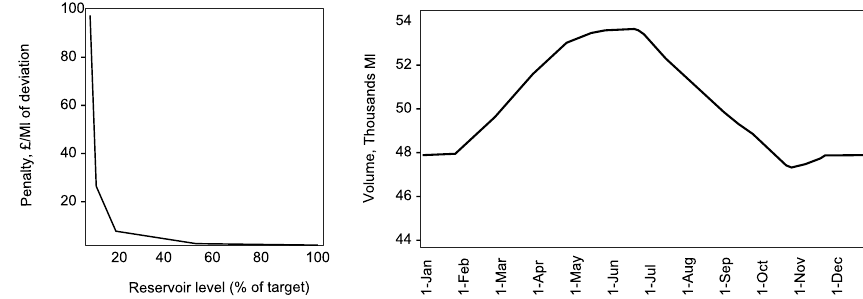
Figure 2. Reservoir storage deviation penalty (left panel), PWS reservoir storage targets (right